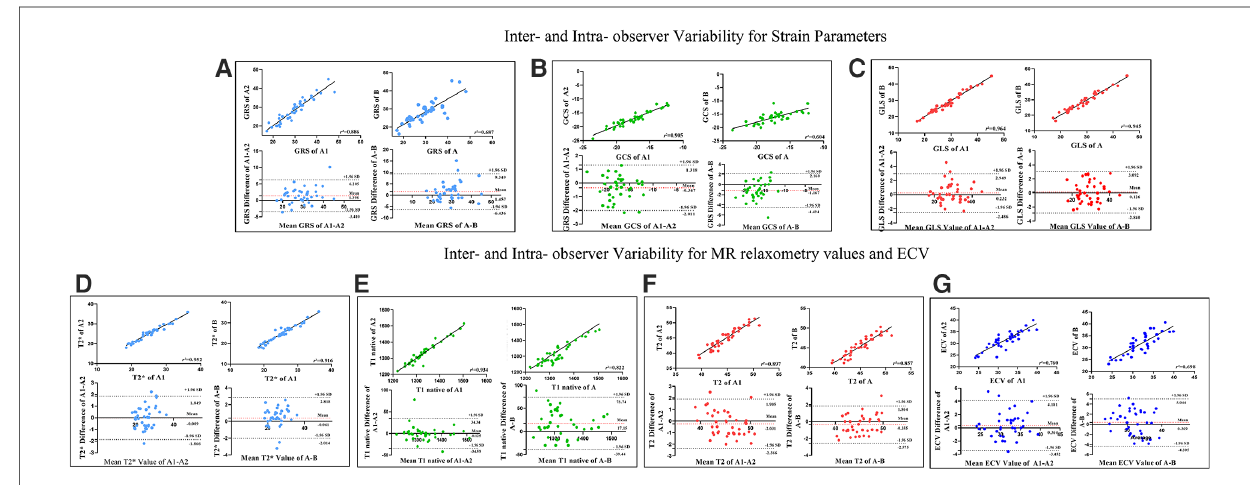
FIGURE 5 Linear Regression and Bland-Altman analyses for GRS (A) , GCS (B) , GLS (C) , T2* values (D) , T1 native (E) , T2 values (F) and ECV values (G) for inter-observer and intra-observer variabilities. The solid line represents bias. The horizontal red dashed line depicts the mean; the two black dashed lines depict the upper and lower limits of agreement (+ 1.96 SD and − 1.96, respectively). A1 The initial measurement of the fi rst observer, A2 one month after the initial measurement of the fi rst observer, A Mean value of A1-A2, B The second observer. Abbreviations as in Figure 1